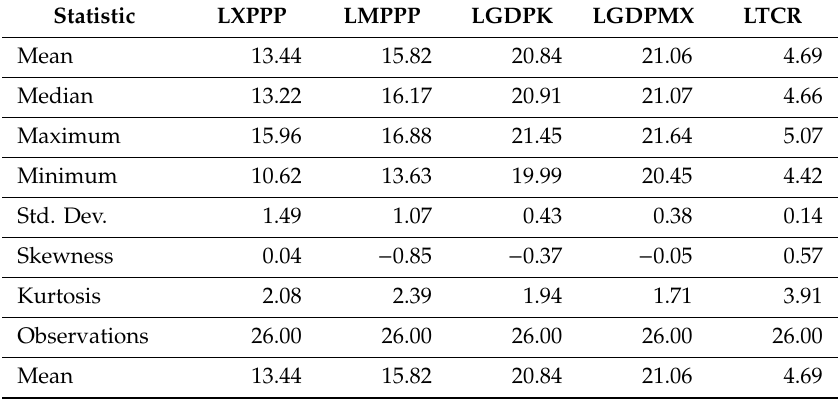
Table A2. Descriptive statistics of logarithmic transformations of data in Table A1.